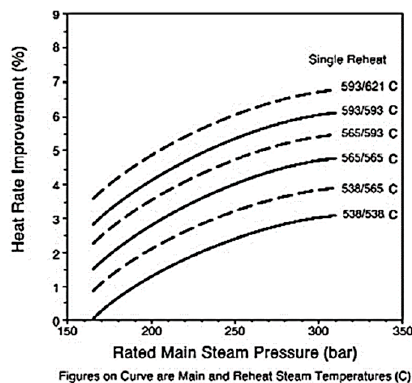
Figure 1. Improvement of heat consumption rate by the steam condition [2] .